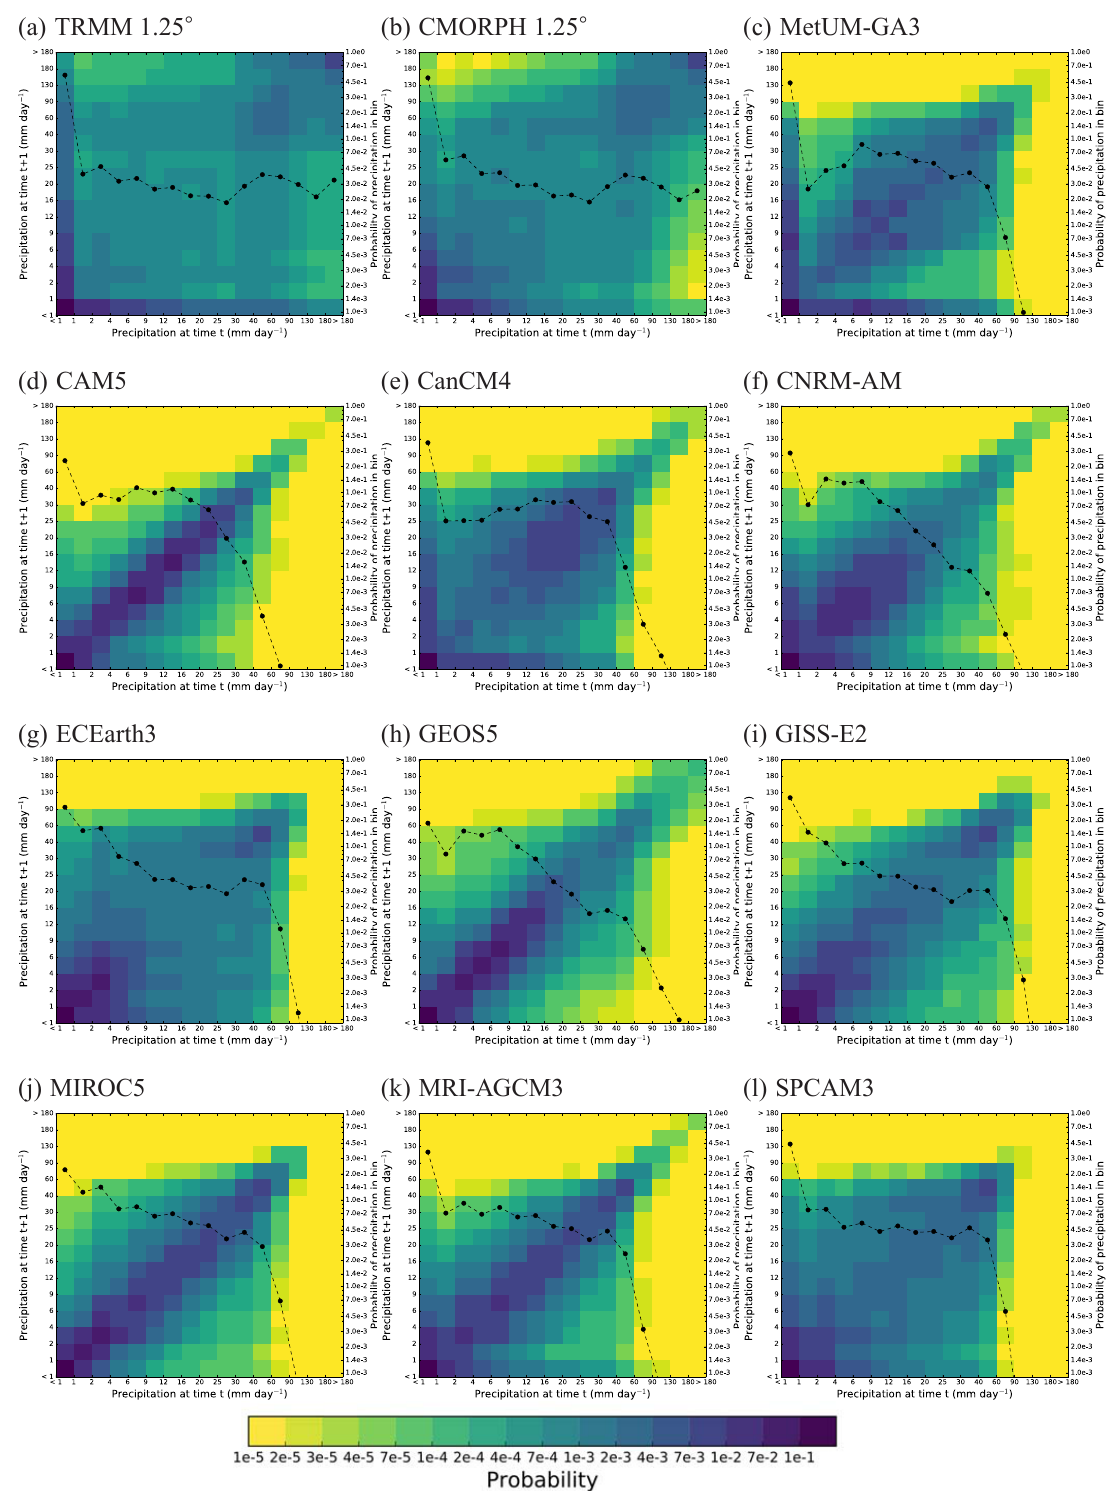
Figure 10. As in Fig. 4, but using 3h mean rain rates instead of time step rain rates and with (a) TRMM 3B42 and (b) CMORPH 3h rain rates for the same temporal period and horizontal domain as the